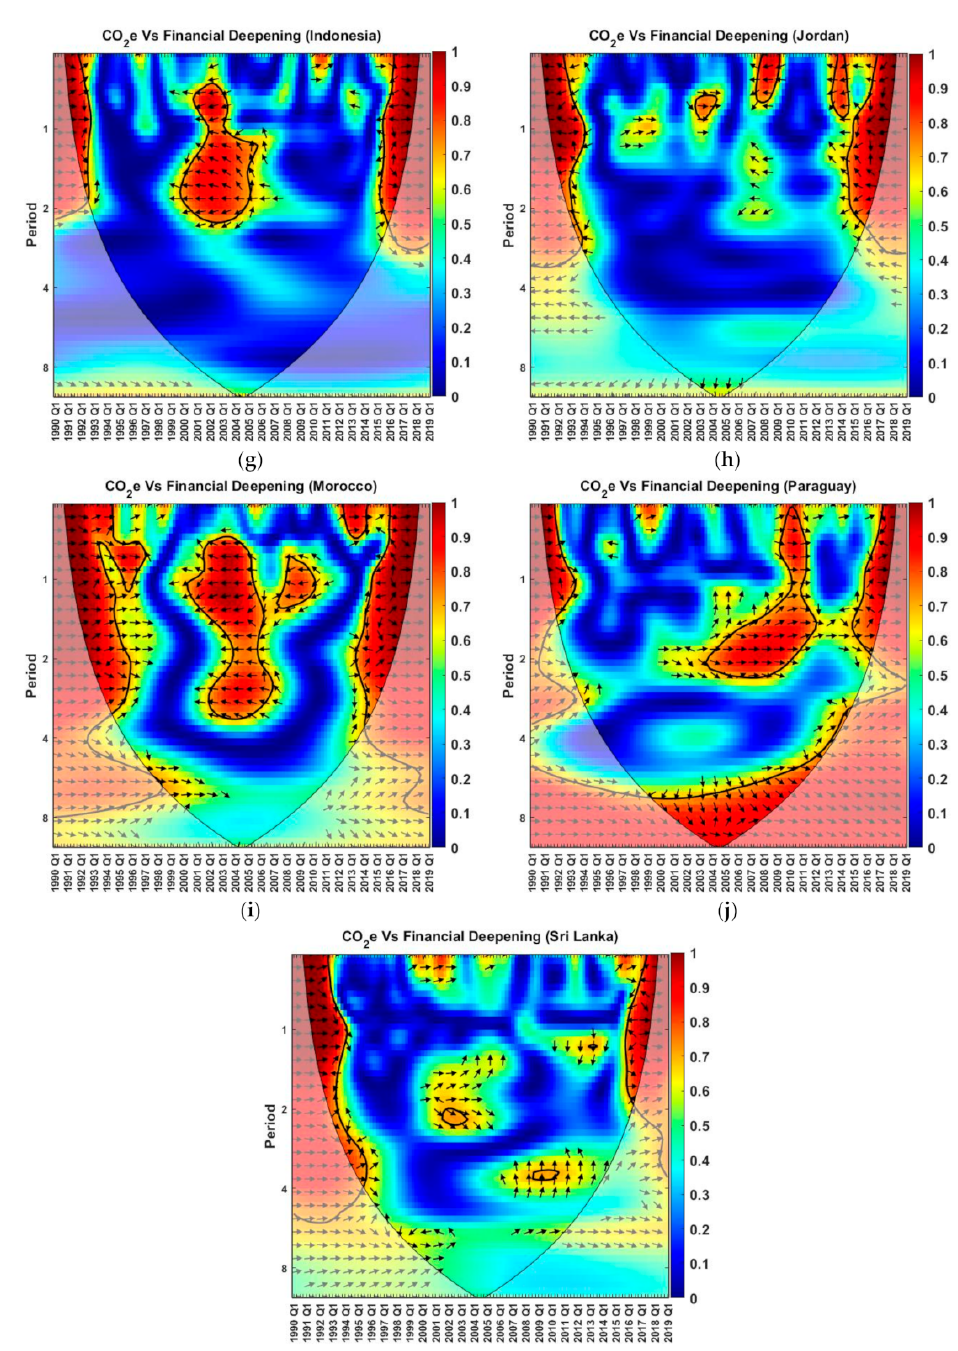
Figure 2. The wavelet coherence between CO 2 e and financial deepening for ( a ) Pakistan, ( b ) Ecuador, ( c ) Croatia, ( d ) El Salvador, ( e ) Georgia, ( f ) Honduras, ( g ) Indonesia, ( h ) Jordan, ( i ) Morocco, ( j ) Paraguay and ( k ) Sri Lanka from 1990 to